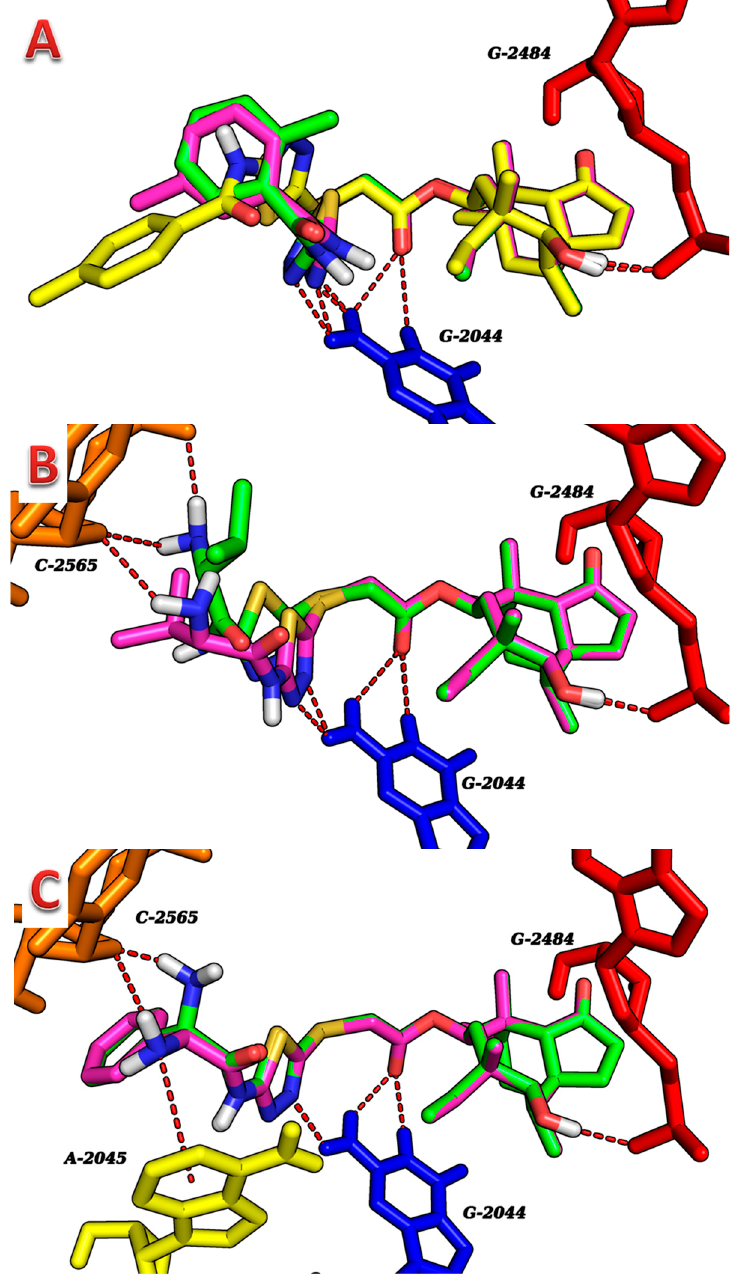
Figure 3. Docking modes of the synthesized compounds into 1XBP. ( A ) 5a (green), 5b (magenta) and 5c (yellow); ( B ) 6a (green) and 6b (magenta) to 1XBP; ( C ) 6c (green) and 6d (magenta). Important residues are drawn in stick and different color. Hydrogen bonds and cation– π interaction are showed as dashed red